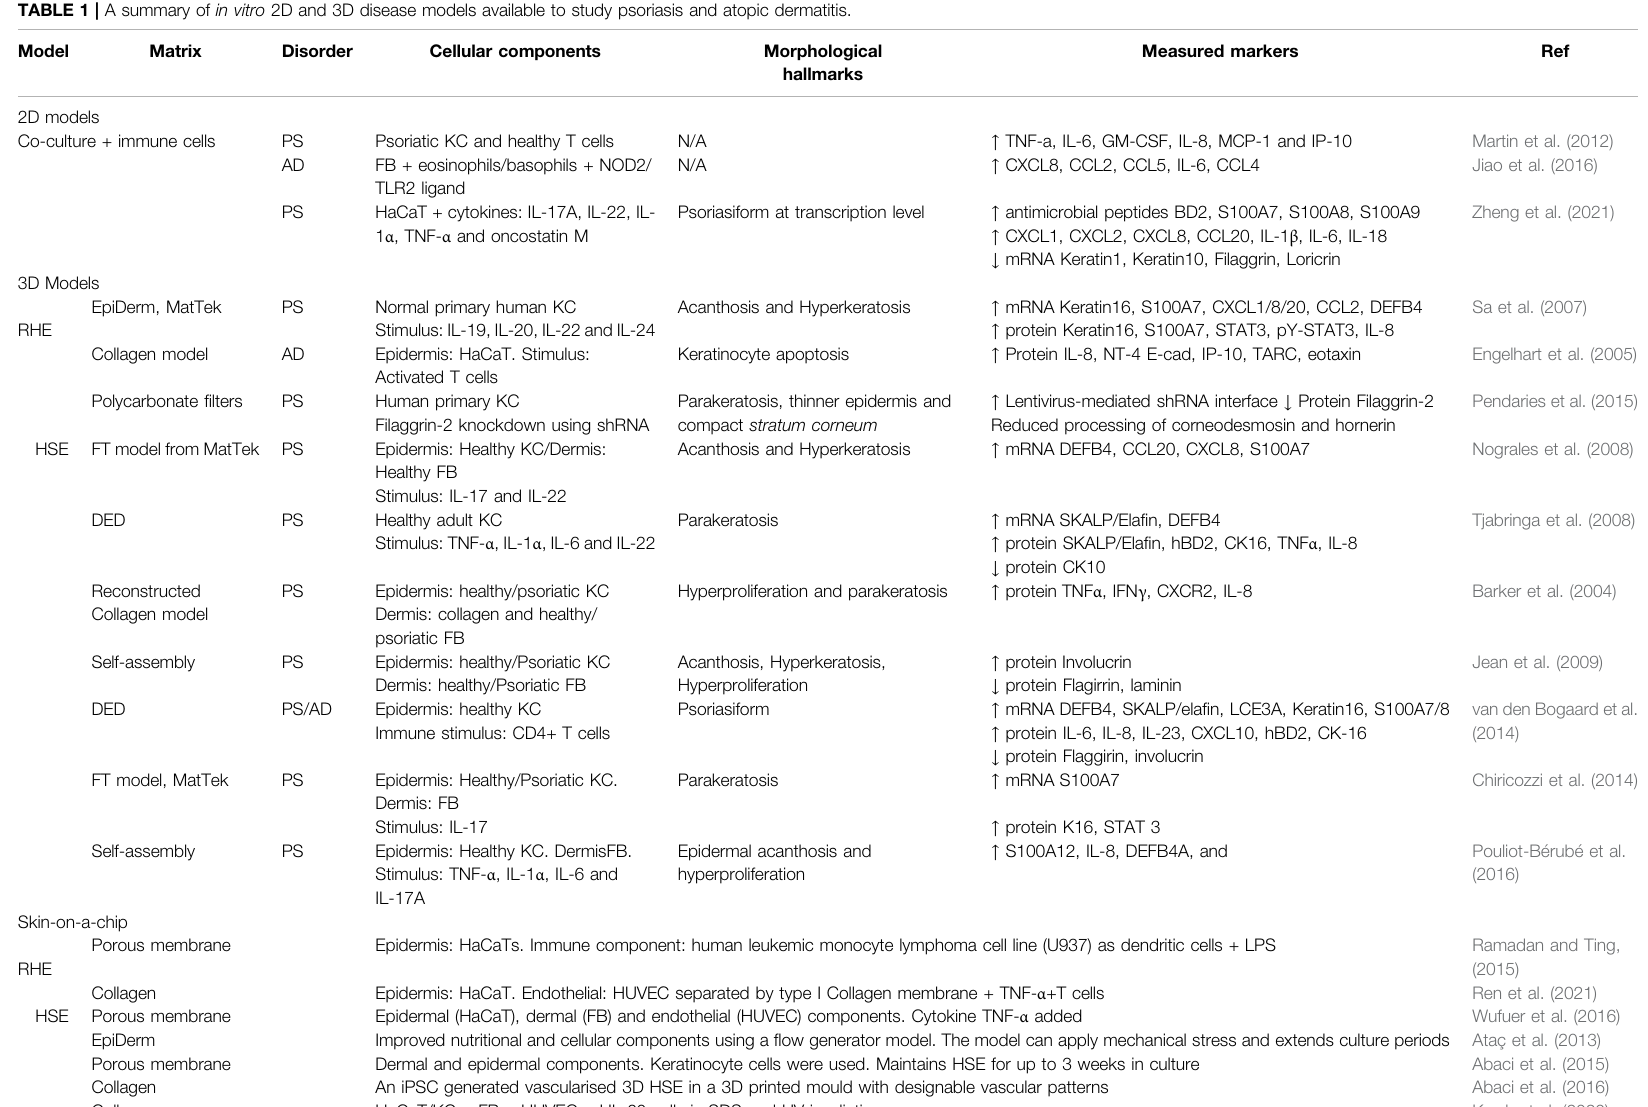
TABLE 1 | A summary of in vitro 2D and 3D disease models available to study psoriasis and atopic